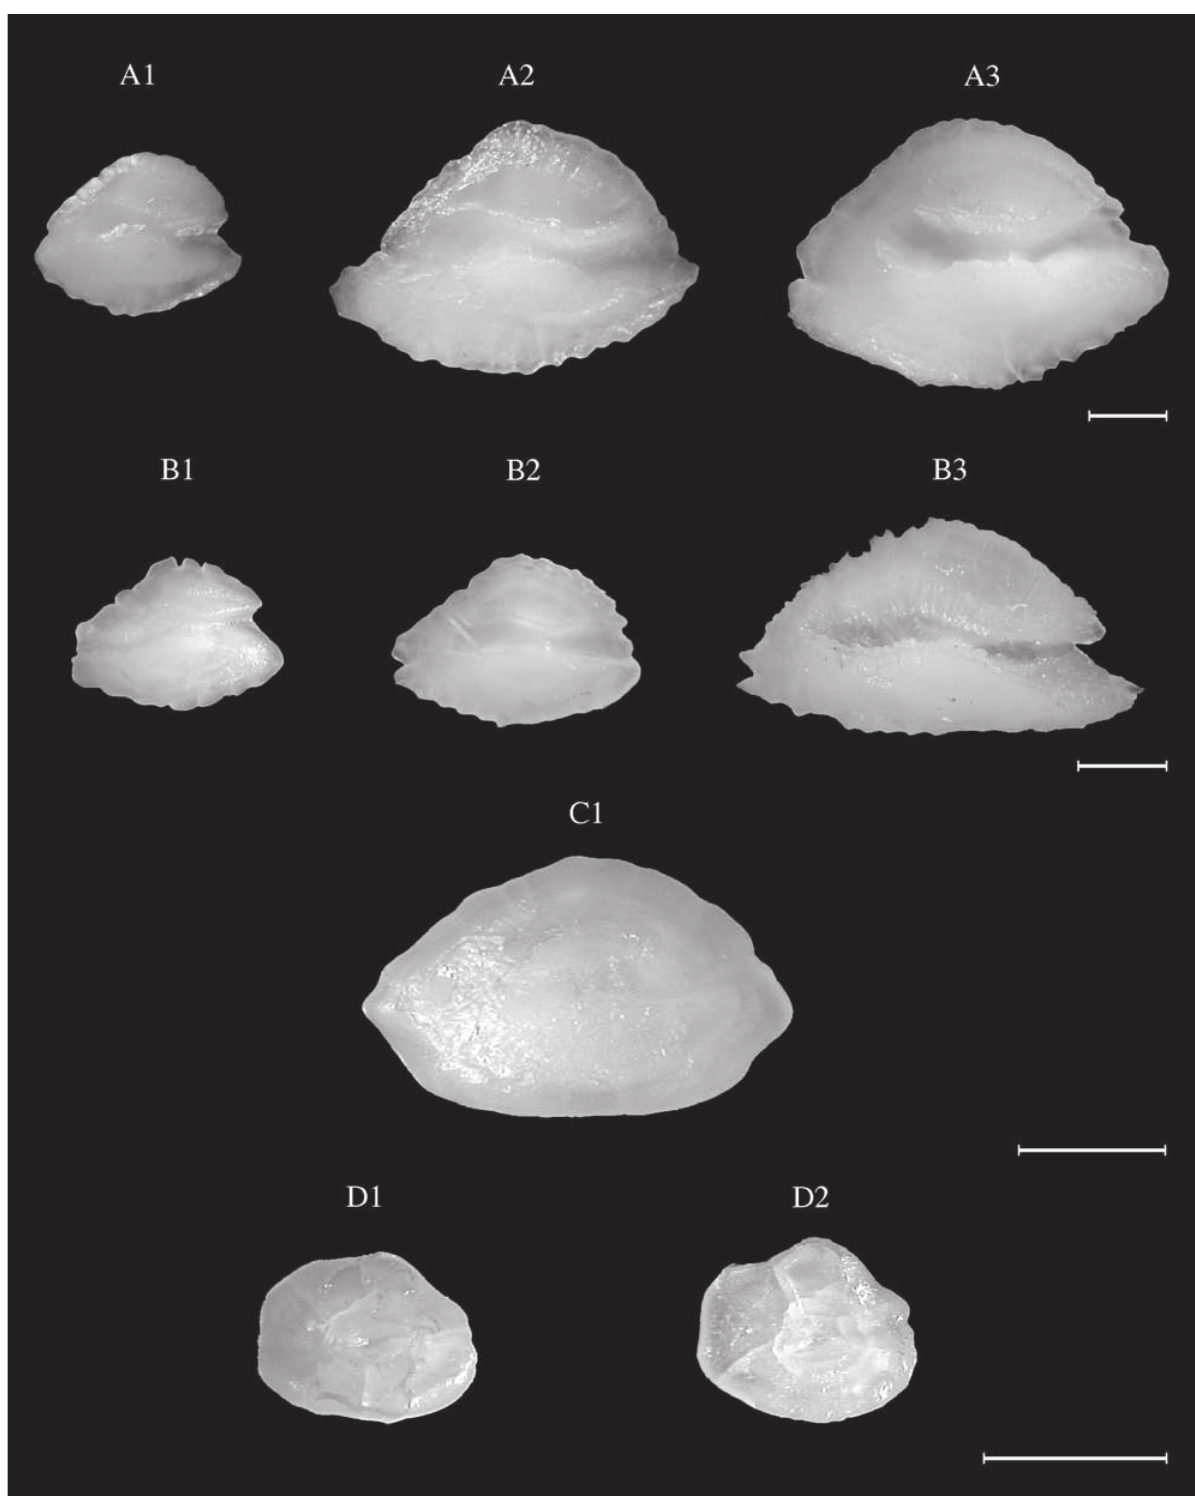
Fig. 45. – Trigla lyra. TL: A1, 9.5 cm (WM); A2, 21.0 cm (WM); A3, 33.3 cm (NEA). Trigloporus lastoviza. TL: B1, 9.0 cm (WM); B2, 12.8 cm (NEA); B3, 23.0 cm (CEA). Peristedion cataphractum (WM). TL: C1, 9.5 cm. Paraliparis lectochirus (WM). TL: D1, 5.9 cm; D2, 6.1 cm. Scale bar = 1